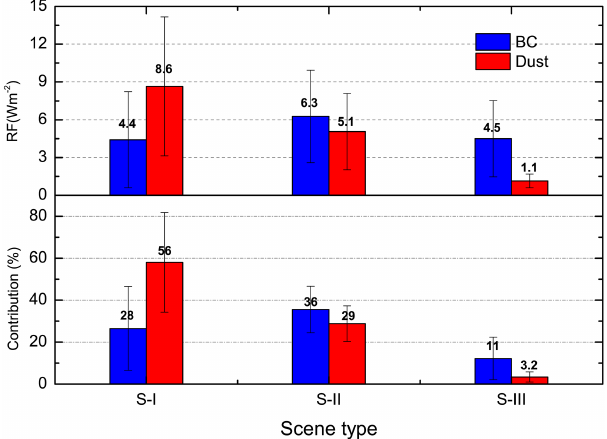
Figure 5. Mid-day RFs of BC and dust on the Zhadang glacier and the contribution (results from the SNICAR model) show the reduc- tion of the albedo in the surface snow cover area under three differ- ent melting conditions: S-I, where the surface of the glacier is bare ice; S-II, where the glacier is covered by aged snow; S-III, where the glacier is covered by fresh snow. Error bars show the